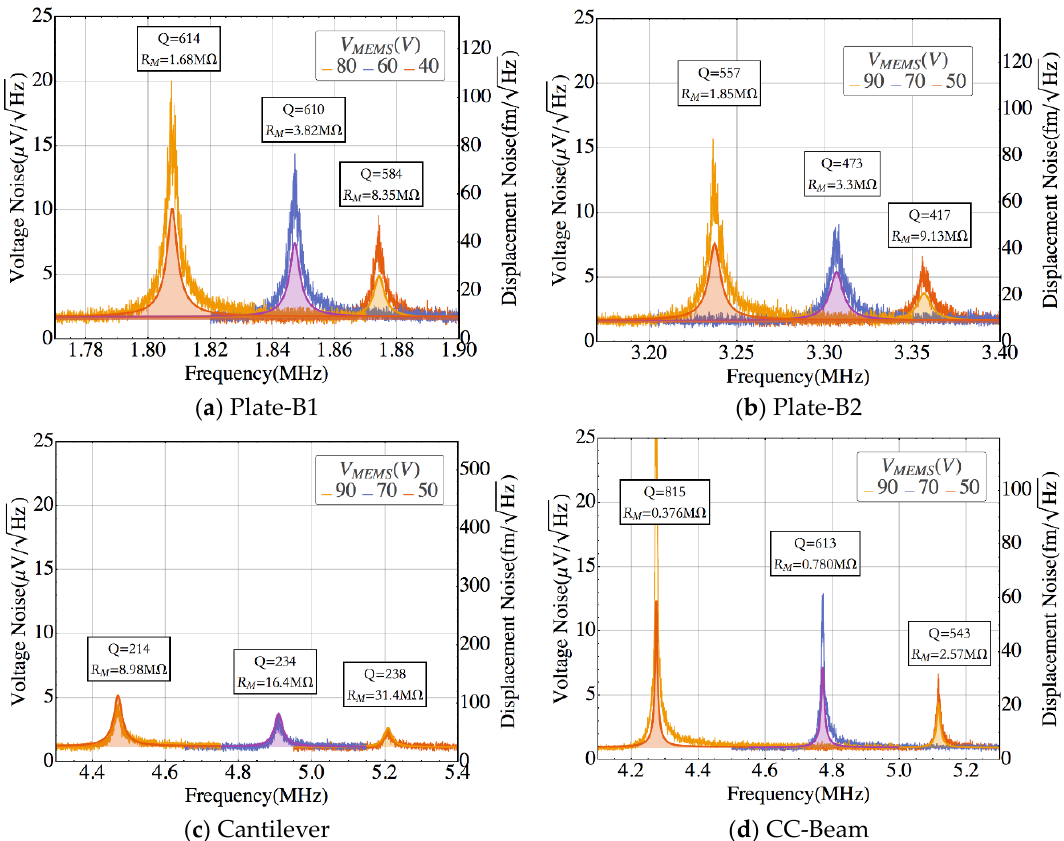
Figure 7. Measured voltage noise spectrum operated at vacuum conditions (P = 10 − 4 mbar), compared to the theoretical model (solid-filled line) for various bias voltages at 20 °C. The values given for Q and 𝑅 𝑀 are derived from experimental data fitting. ( a ) Plate-B1, ( b ) Plate-B2, ( c ) Cantilever, and ( d ) CC-Beam.